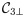
This figure illustrates how well exactly conserved quantities are preserved by our symplectic numerical solvers, compared to the standard Runge-Kutta methods implemented in scipy.integrate.solve_ivp.For the 3-site Toda lattice, reduced to relative coordinates, the constants of motion are the Hamiltonian H⊥ of Eq (11) and C3⊥ of Eq (12). Here ΔH⊥ = [H⊥(t) − H⊥(0)]/H⊥(0), calculated from the numerical solutions, and similar for ΔC3⊥. Here τ is the fixed timestep of the sympletic solvers.